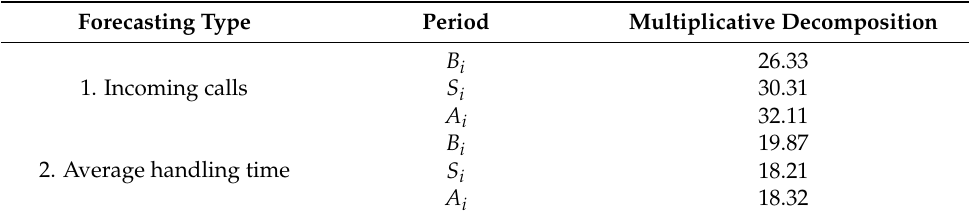
Table 7. The MAPEs for data type